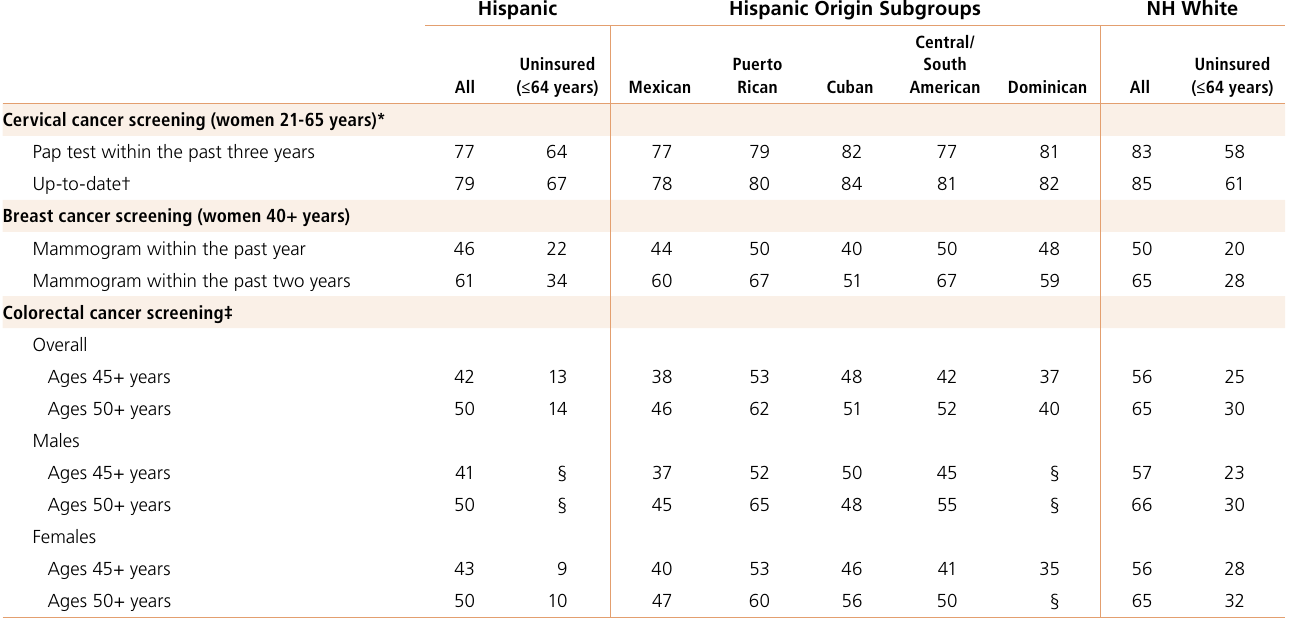
Table 8. Cancer Screening Test Use (%), Adults, US,